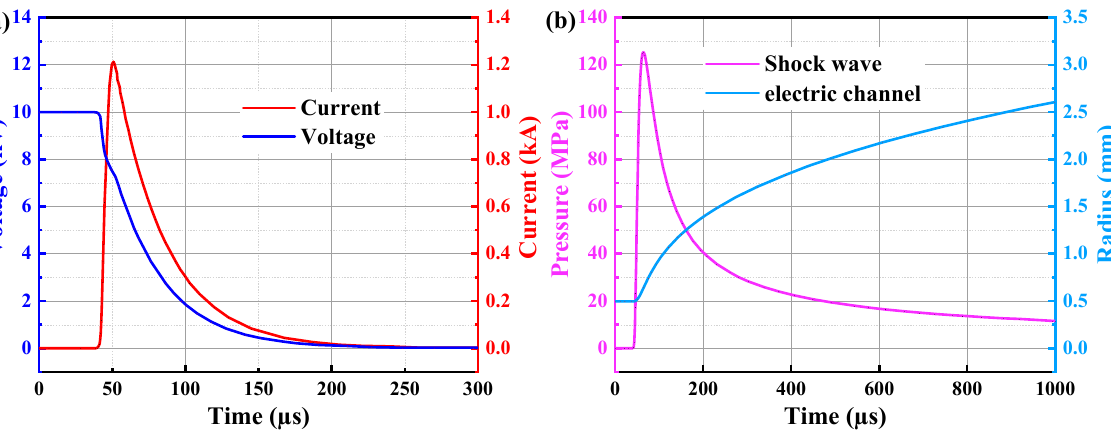
Figure 16. ( a ) Current and Voltage of circuit, ( b ) shock wave pressure and radius of electric channel under